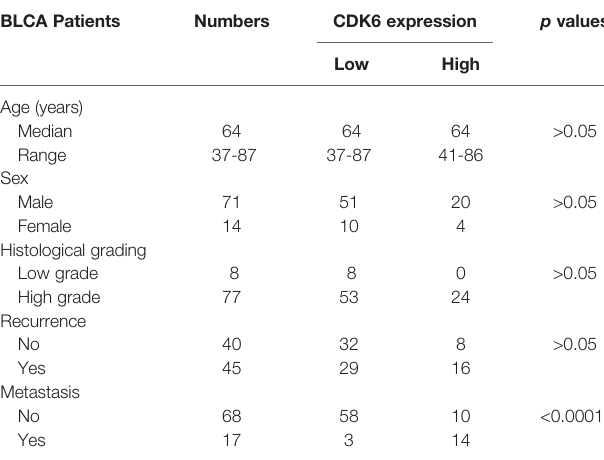
TABLE 2 | Correlation of CDK6 expression and clinical-pathological features in Bladder carcinoma (BLCA). BLCA Patients